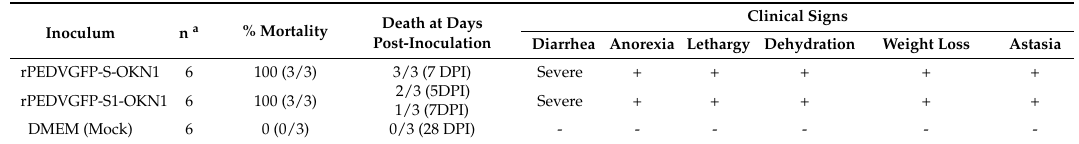
Table 3. Clinical signs in piglets inoculated with S-chimeric and S1-chimeric PEDV strains, and culture medium (Mock).